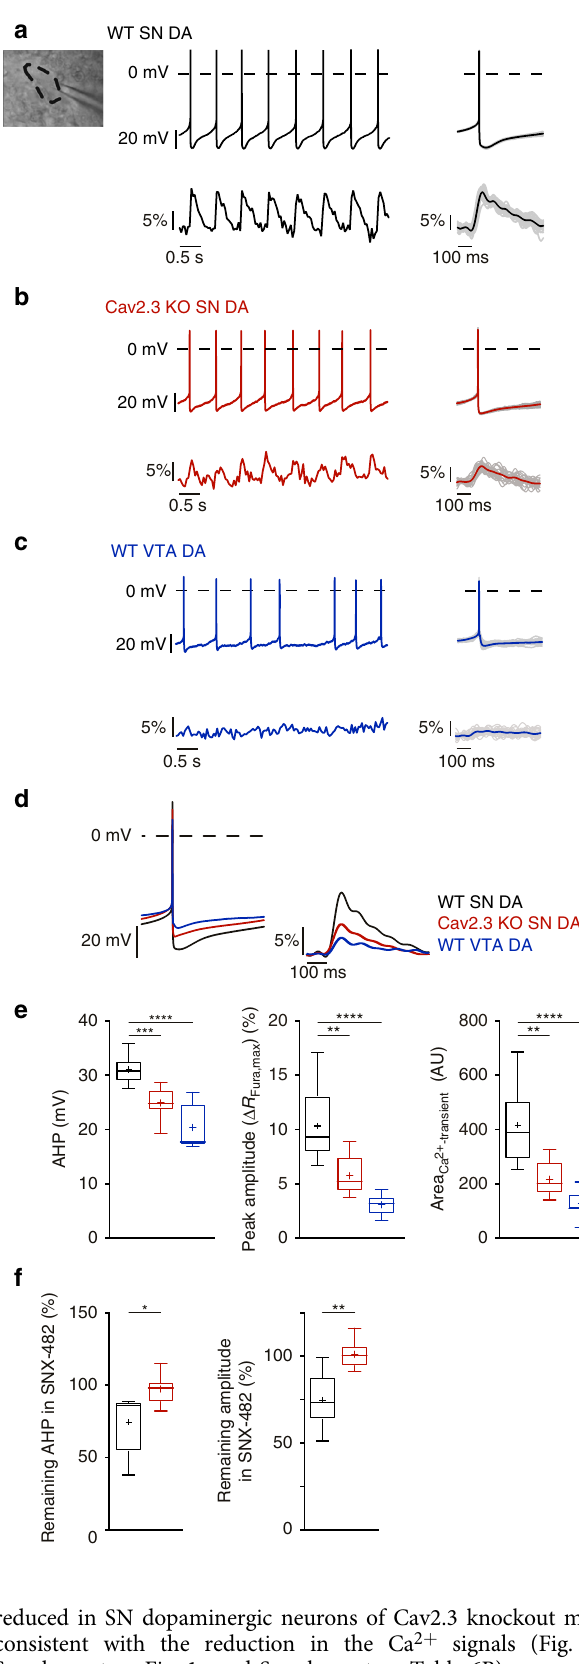
Fig. 2 Cav2.3 contributes to somatic action potential-related Ca 2 + oscillations in adult mouse SN dopaminergic neurons. a – c Neurons were recorded in the perforated patch-clamp con fi guration while somatic Ca 2 + dynamics were simultaneously imaged (insert a ). Left: Continuous recordings of a wildtype SN dopaminergic (DA) neuron ( a ), Cav2.3 knockout SN dopaminergic neuron ( b ), and wildtype VTA dopaminergic neuron ( c ) illustrating the action potential (AP) fi ring and the associated Ca 2 + oscillations. Right: Mean of 20 APs and associated mean Ca 2 + oscillations for the neurons from the left. Individual traces are superimposed in grey. d Average spikes (left) and Ca 2 + transients (right) of wildtype SN dopaminergic (black trace, n = 15), Cav2.3 knockout SN dopaminergic (red trace, n = 12), and wildtype mesolimbic VTA dopaminergic (blue trace, n = 7) neurons. e Plots showing AP after- hyperpolarizations (AHP, left), peak Ca 2 + amplitudes (as Δ R Fura,max , middle) and area under the curve (right, AU arbitrary units) of AP-induced Ca 2 + transients during pacemaking at ~1.5 Hz. f Remaining AHP and amplitude of the action potential evoked Ca 2 + signals (see Methods) in SN dopaminergic neurons of Cav2.3 wildtype ( n = 6) and Cav2.3 knockout ( n =